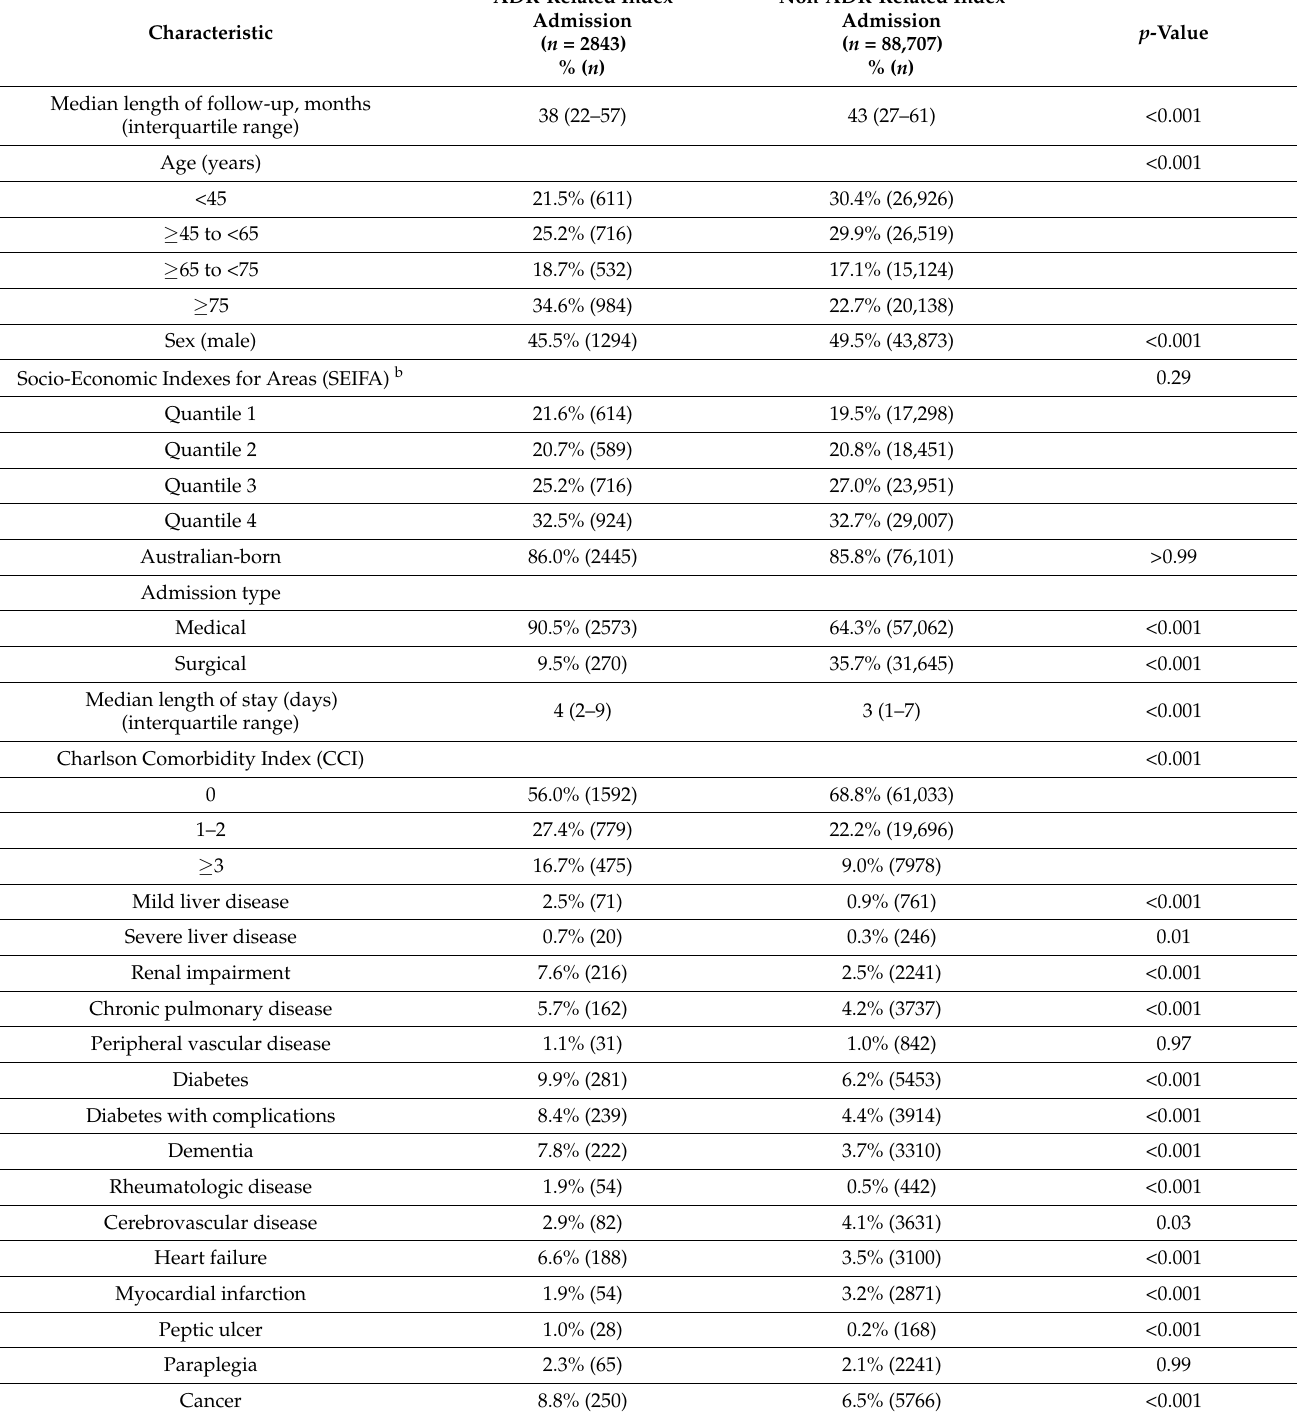
Table 1. Patient characteristics at baseline a